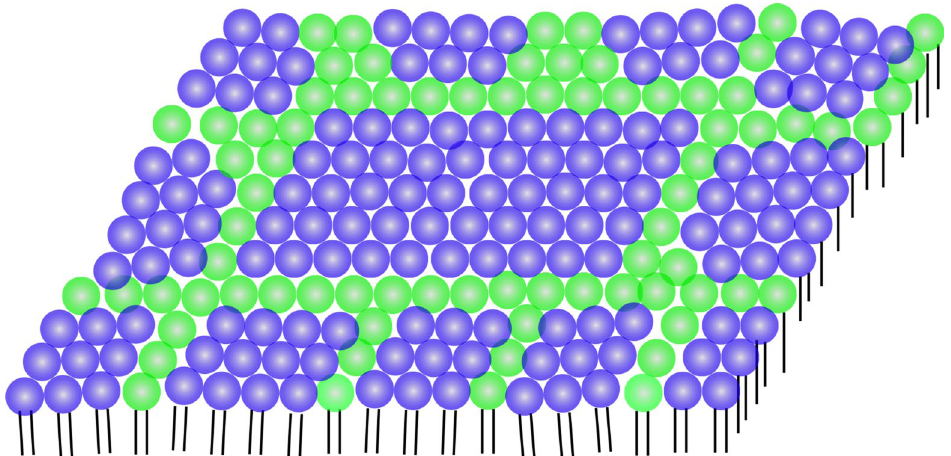
Figure 7. A schematic illustration of the distribution of the subdomains inside a single ordered domain. Blue and green lipids correspond to DSPC and DOPC,